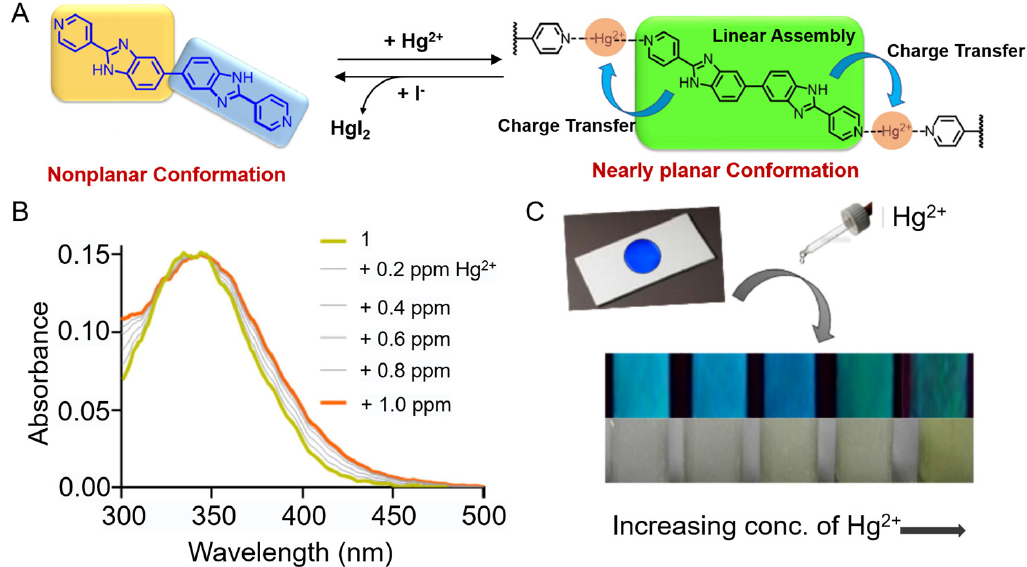
Figure 5. ( A ) Schematic diagram shows simultaneous sensing of Hg 2+ and I − via reversible supramolecular assembly formation. ( B ) Titration of 1 20 μ M) with Hg 2+ (0–1 ppm) in the presence of 0.1 mg/mL HSA at pH 7.0. ( C ) Hg 2+ induced changes in the color of paper strips (0–2 ppm) under normal daylight and UV light. Reproduced from [92] with permission from Elsevier, copyright 2021.